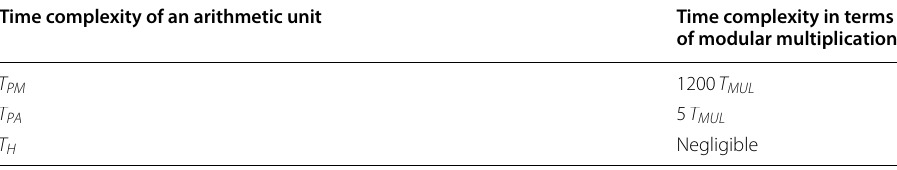
The Hash computation cost ( T H ) is much less than the private and public keys computation costs ( T PU and T PR ) Table 7 Unit conversion of various operations in terms of T MUL Time complexity of an arithmetic unit